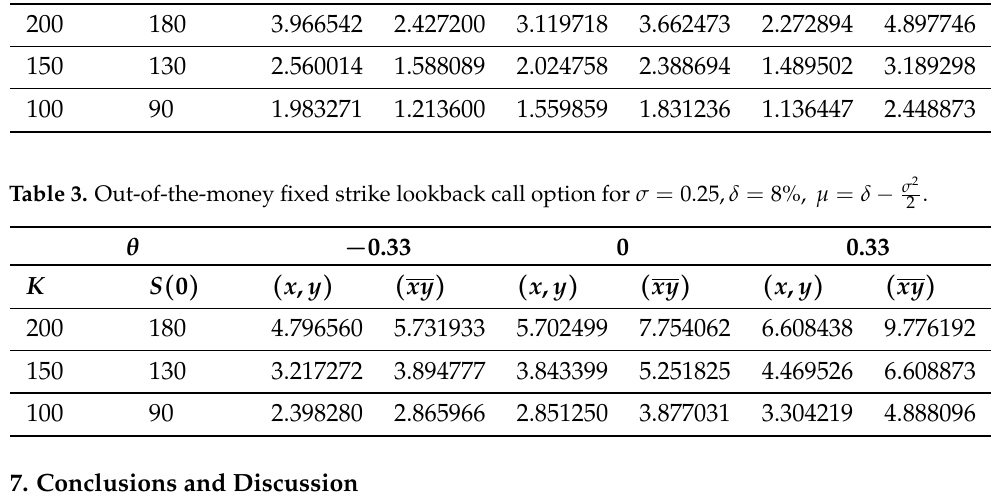
Table 2. Out-of-money put option for σ = 0.25, δ = 8%, µ = δ − σ 2